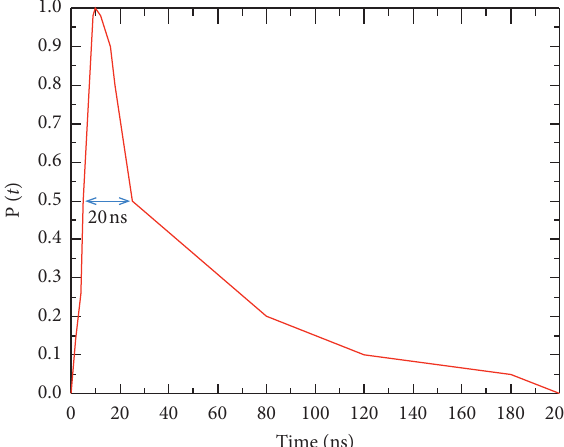
Figure 3: Time distribution model of shock wave pressure.